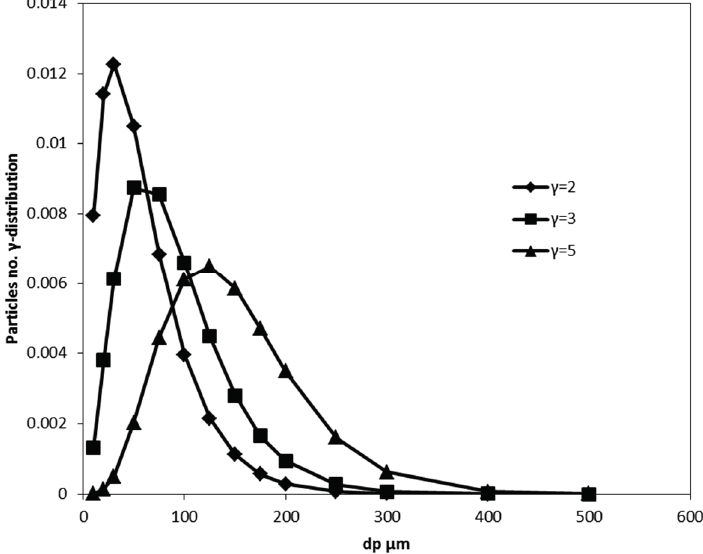
Figure 14. Assumed particles number distribution, B =